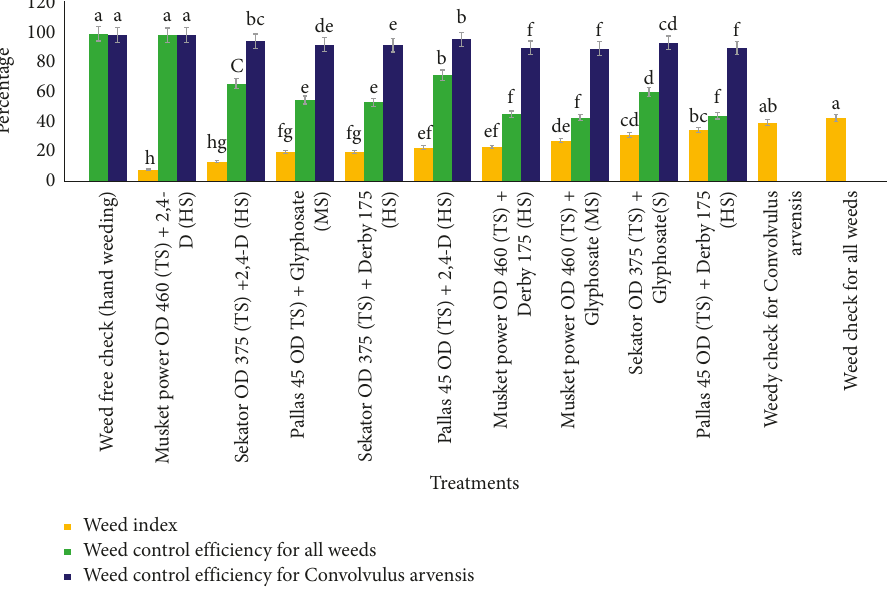
Figure 2: Different weed control treatments’ effects on the weed index, herbicide control efficiency for all weeds, and Convolvulus arvensis in tef (combined mean of 2020 and 2021 years). TS, tillering stage; HS, heading stage; and MS, maturity stage. Means followed by the same letter in the bar graphs are not significantly different according to Fisher’s protected LSD at P < 0 .